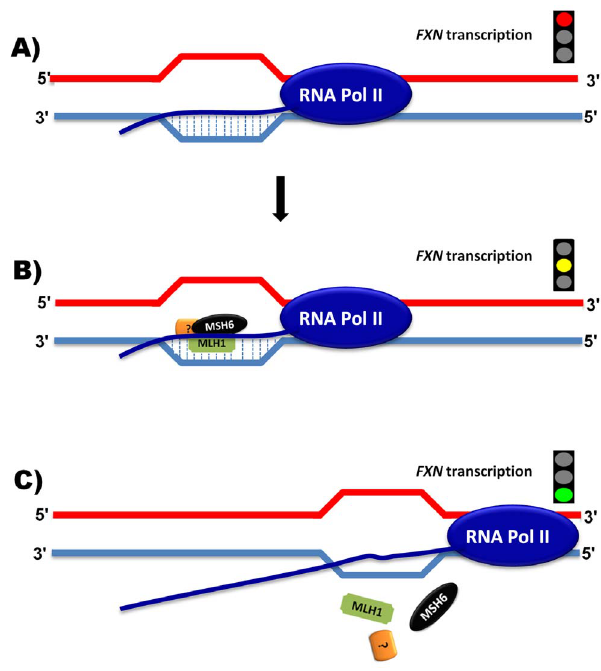
Figure 8. Proposed mechanism of MLH1 action on FXN transcription. Images illustrate: ( A ) inhibition of transcription by triplex DNA N RNA R-loop formation; ( B ) binding of MLH1 and MSH6 to the R-loop, together with other unknown factors (?), and ( C ) release of bound premature mRNA to allow continuation of transcription.